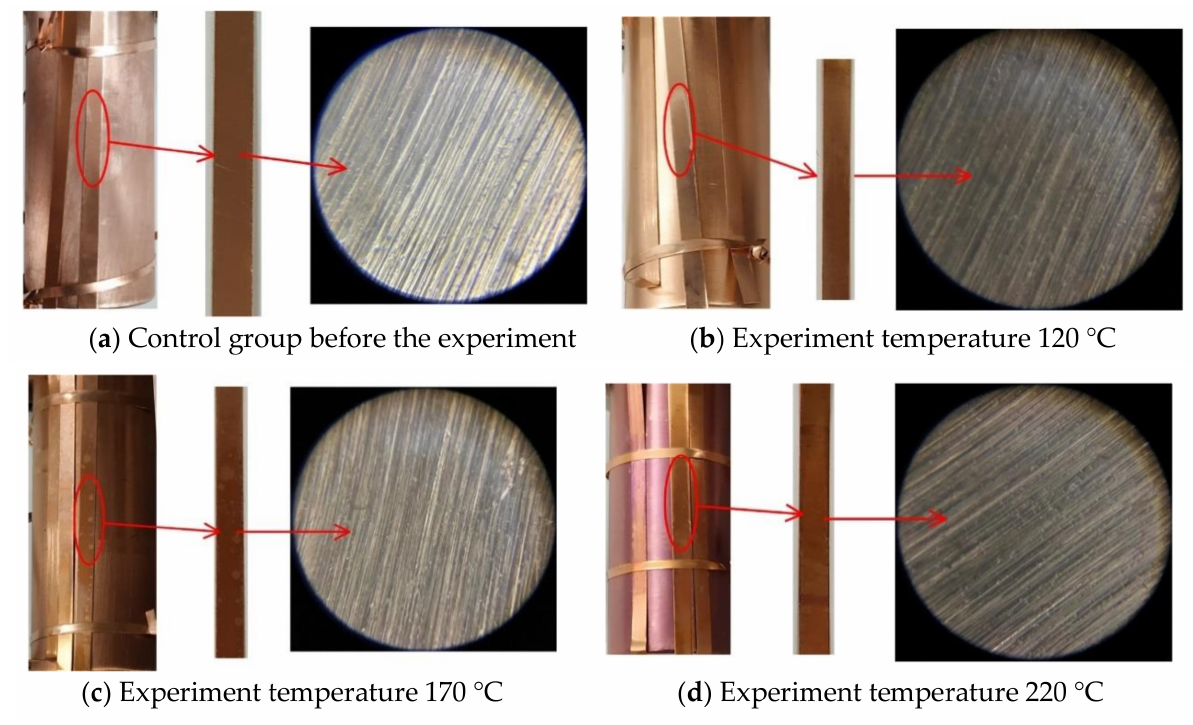
Figure 2. Surface photo of copper before and after contact with C 5 F 10 O/N 2 gas